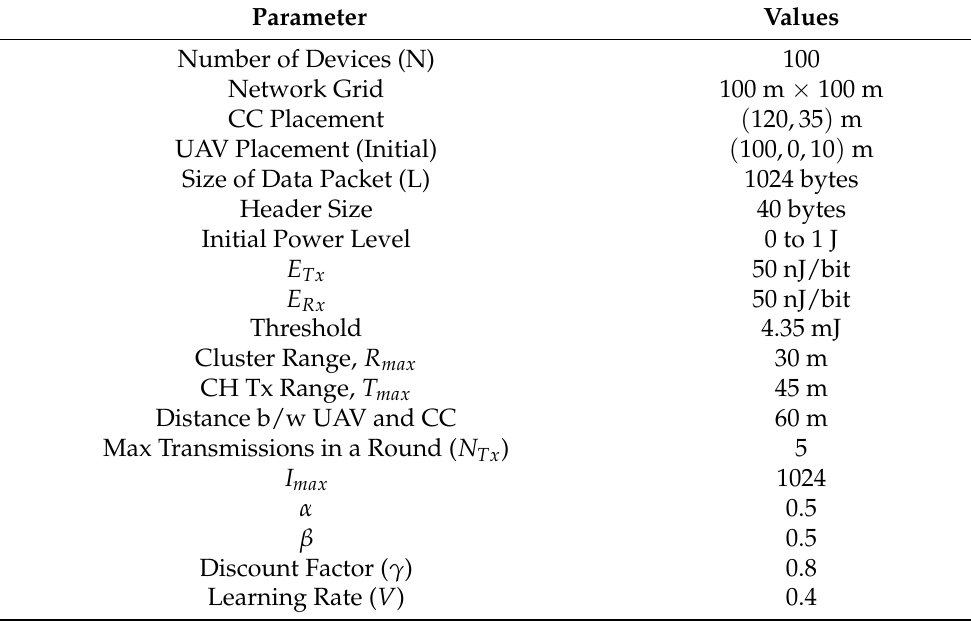
Table 3. Simulation parameters.